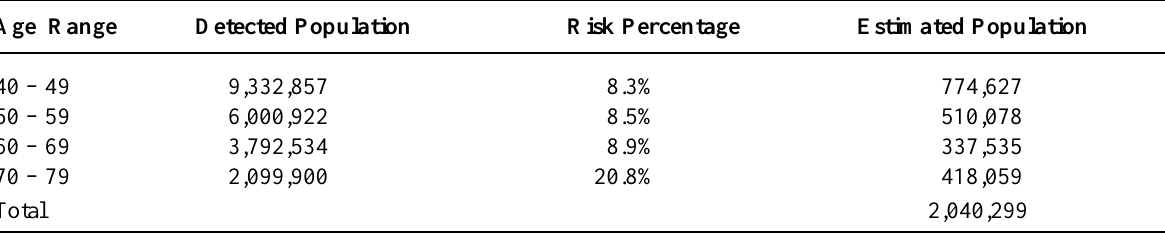
Table 5 – Estimated risk population subjected to surgical treatment, according to age range in years.